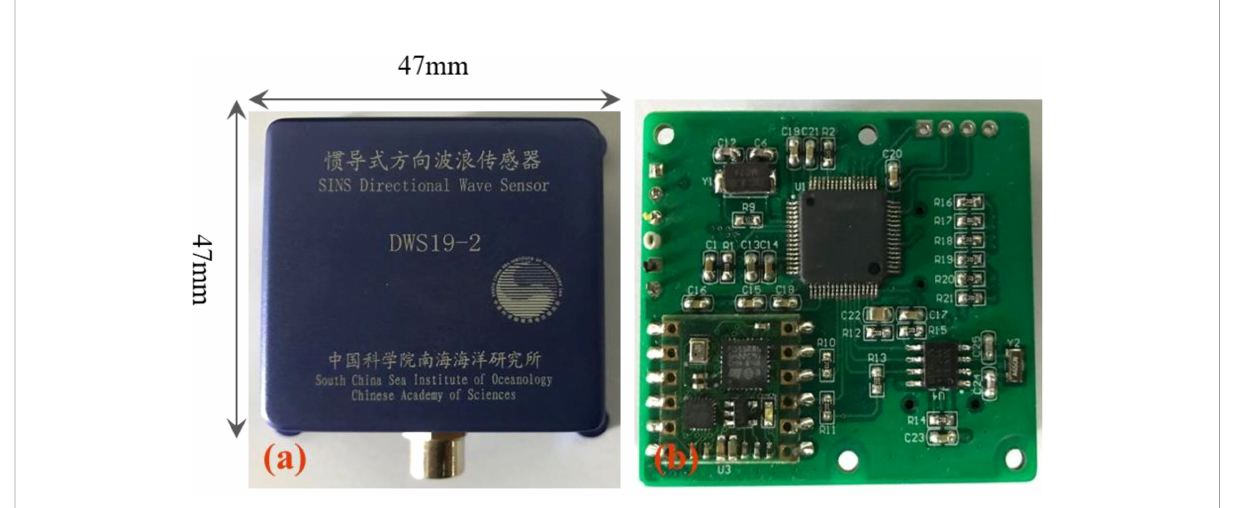
FIGURE 1 DWS19-2 directional wave sensor: (A) physical picture; (B) signal processing